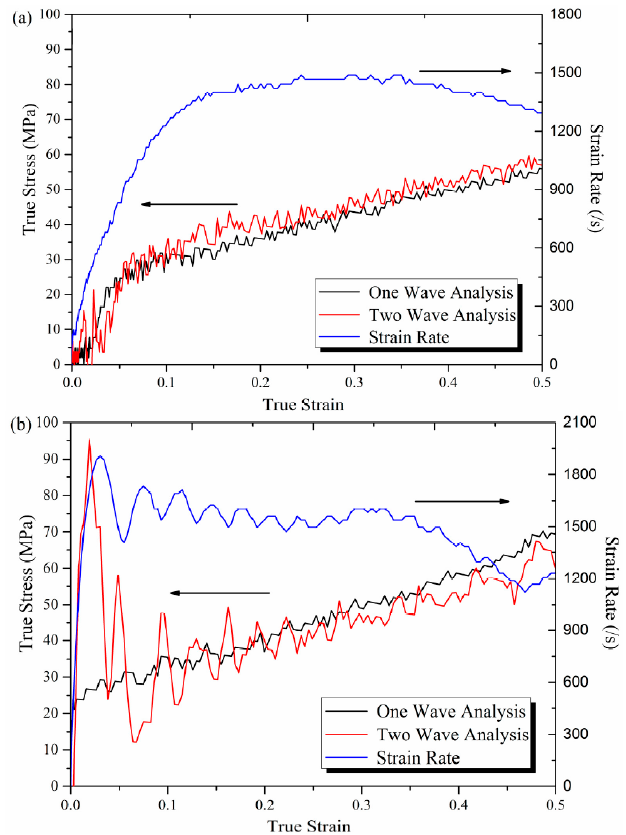
Figure 5. One-wave versus two-wave analysis and strain rate of Al-PTFE ( a ) with pulse shaping and ( b ) without pulse shaping.